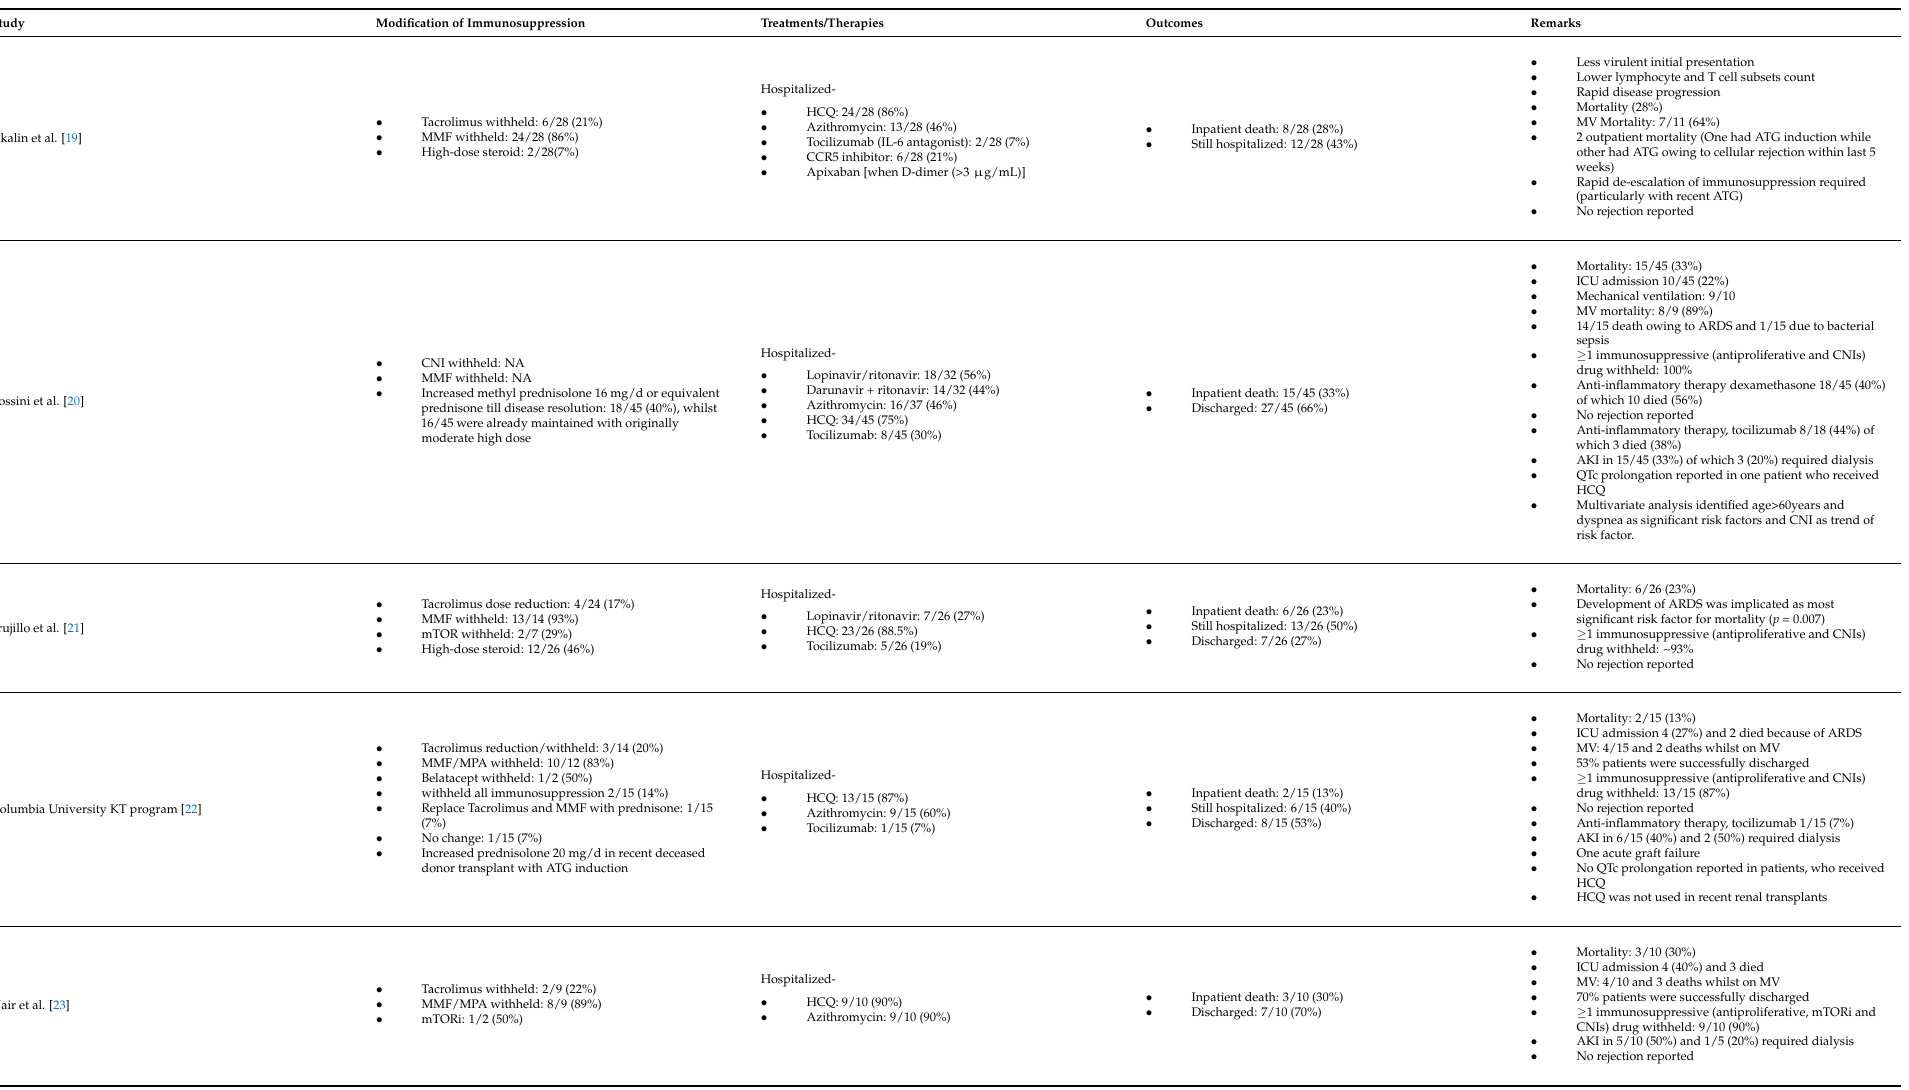
Table A3. Reported interventions and outcomes for KT patients with